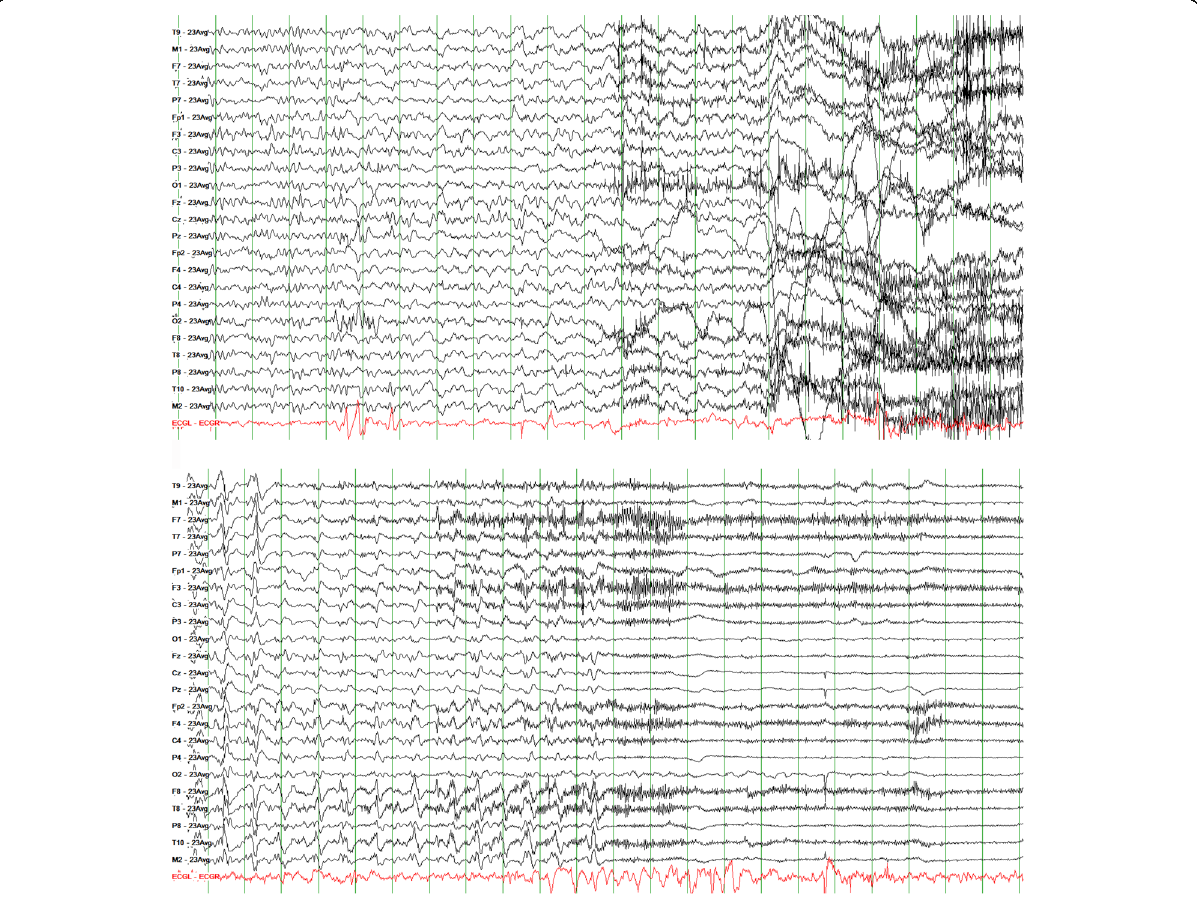
Fig. 1 Top panel showed 7-8 Hz EEG background and unclear ictal onset that was obscured by diffuse muscle artifacts. Bottom panel showed ictal offset and postictal generalized EEG suppression that occurred in the presence of stable vital signs including heart rate, blood pressure and oxygen saturation as shown in Fig. 3. EEG recording settings: high pass filter 1 Hz and low pass filter 50 Hz. Sensitivity: 10 μ